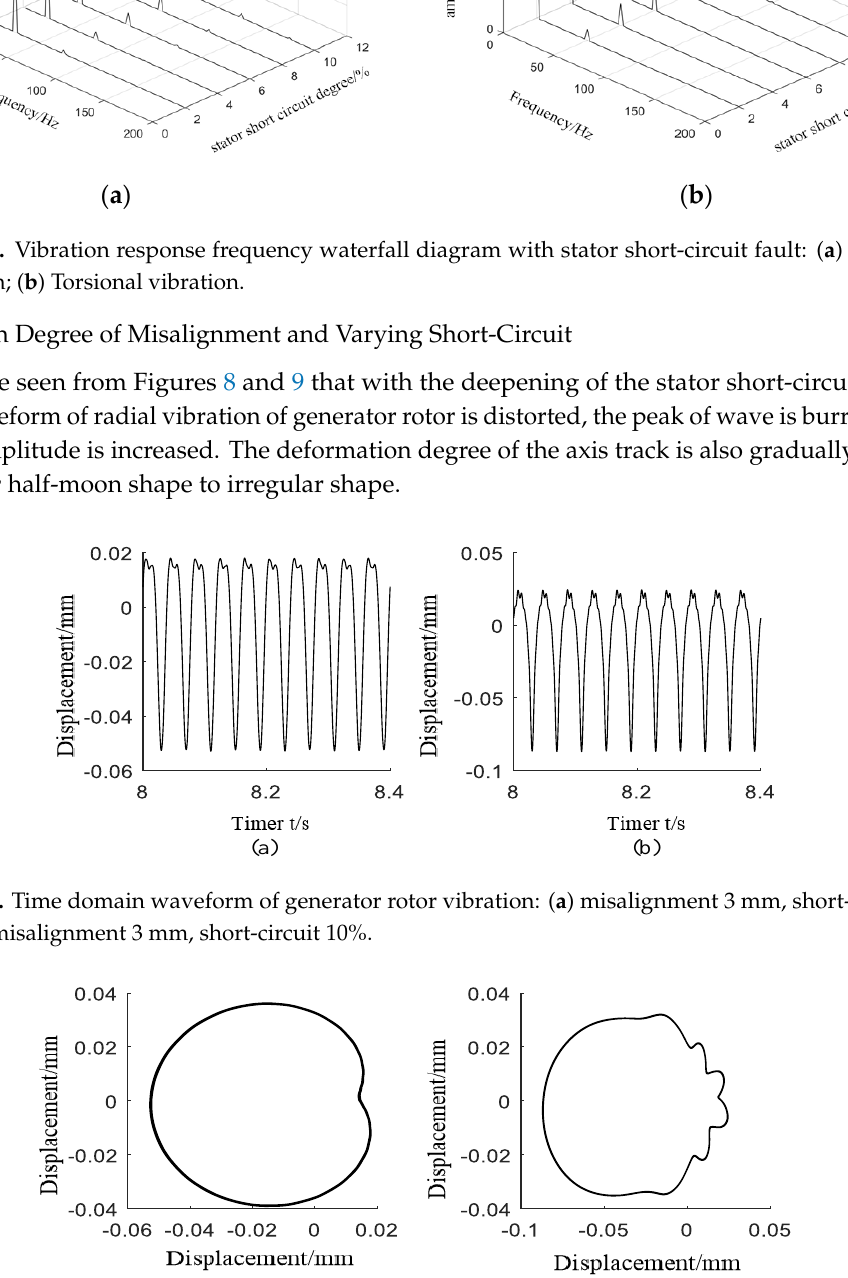
Figure 7. Vibration response frequency waterfall diagram with stator short-circuit fault: ( a ) Radial vibration; ( b ) Torsional vibration.